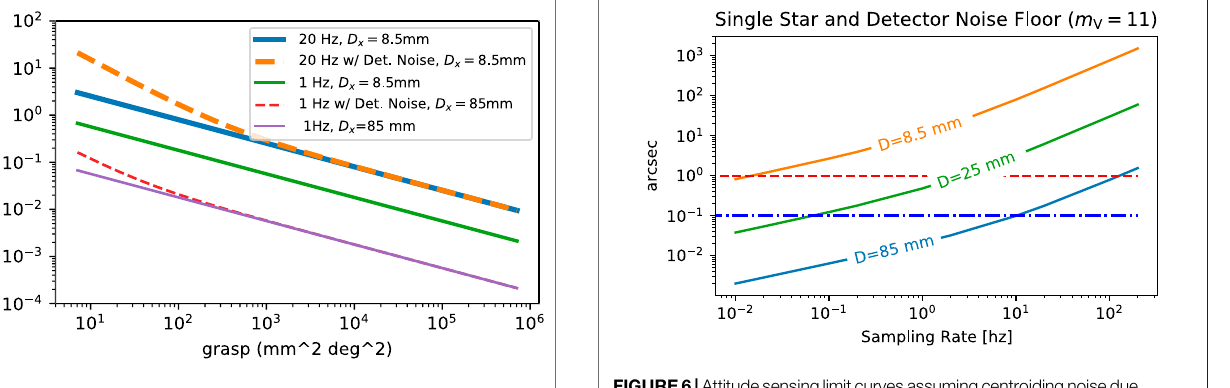
FIGURE 5 | Attitude determination error versus system grasp or étendue . This photon noise limited case assumes the fl ux per square degree at the galactic polesfor starsfrom zero tothe13thmagnitude,( Figure 4 ).The upperboundonthe x -axiscorrespondstoatelescopewithadiameterof 85 mm with a ten-degree circular FOV. The 20-Hz curve is shown to emphasize the importance of short exposure times. At low grasps, the detector noise dominates, while at large grasps, the photon noise dominates. Smallvaluesof D x show the importance ofthe sensor aperture toconstraining bodypointing;itshouldbenotedthatthelargestgraspsarelikelytorequirean impractically large FOV for D x (cid:2) 8.5 mm.